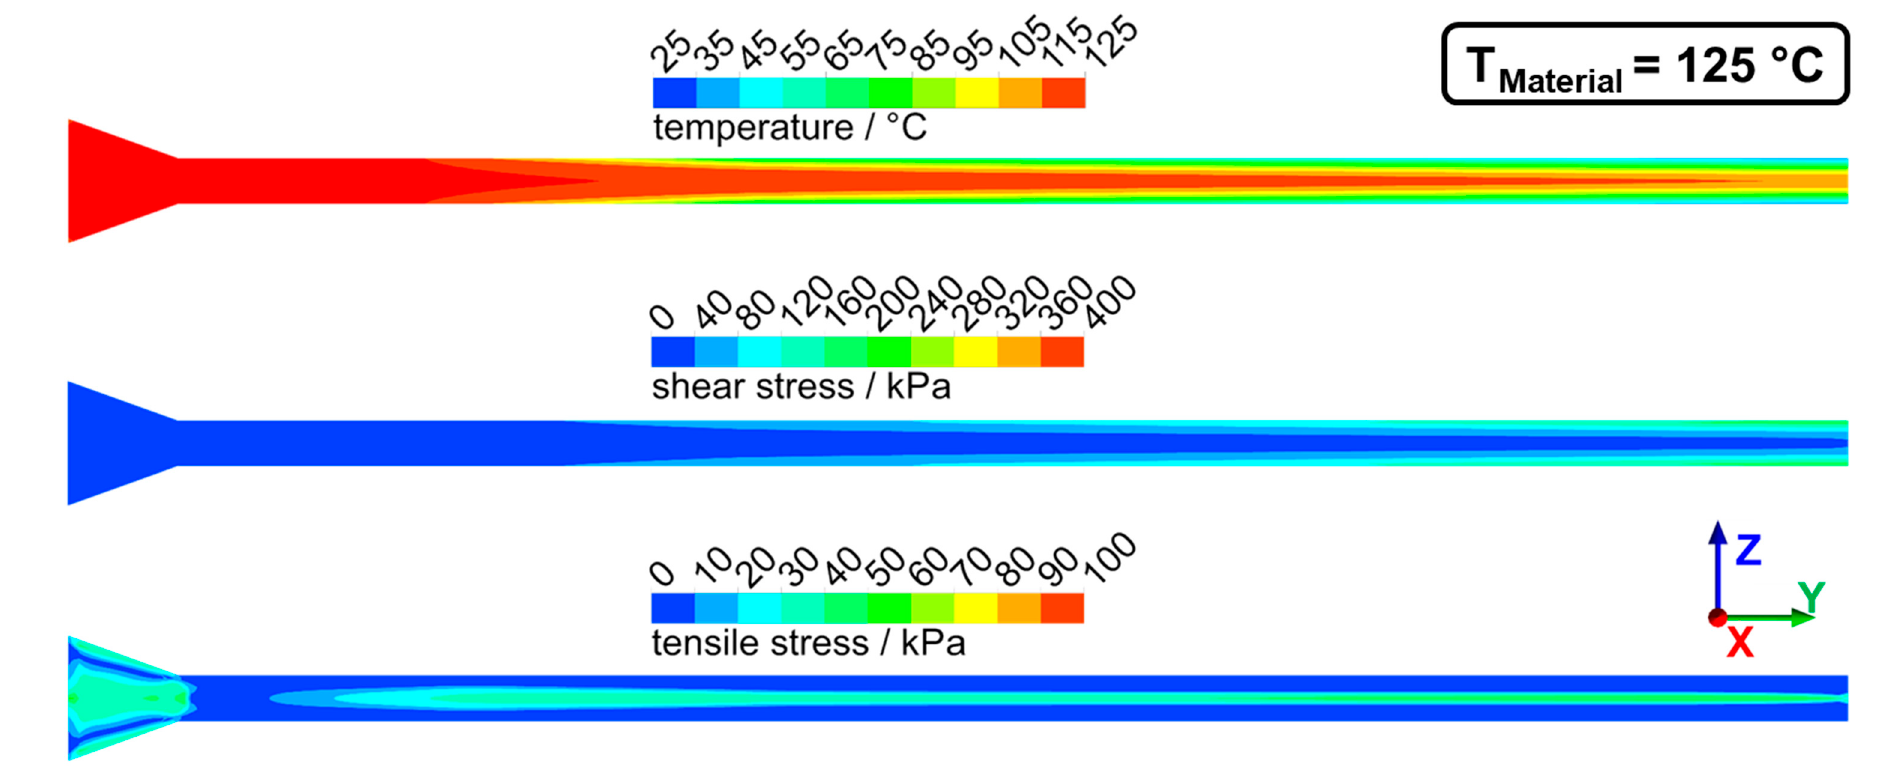
Figure 10. Temperature, shear stress, and tensile stress distribution in the die section of extrusion trials with T Material = 125 °C. The lateral view is displayed, flow direction from left to right (in the y-direction).